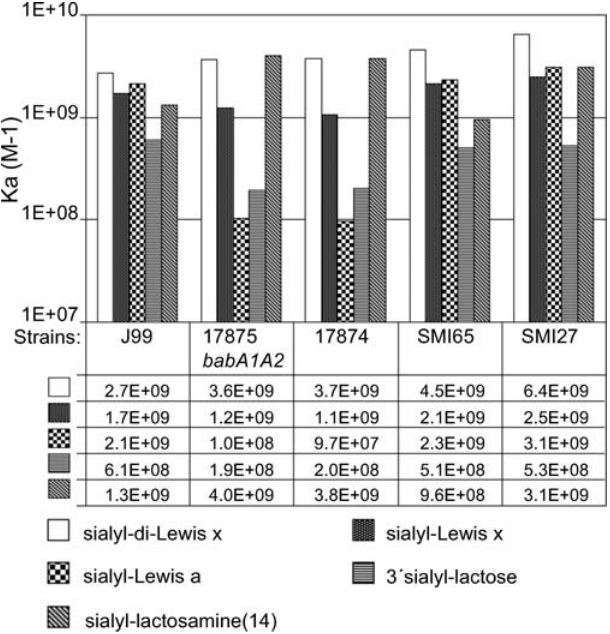
Figure 4. Binding Affinities Analyzed According to Scatchard of H. pylori Reference Strains, a babA Deletion Mutant, and Clinical Isolates for Sialylated Glycans DOI: 10.1371/journal.ppat.0020110.g004